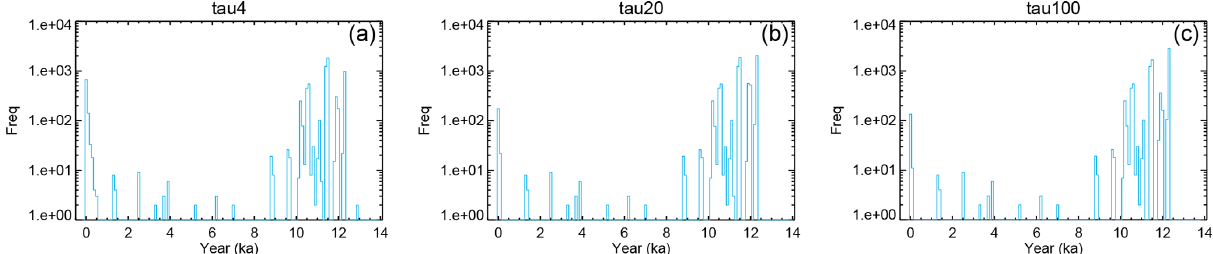
Figure 7. Histograms of circum-Arctic basal age distribution of the SOC accumulation for different values of τ : (a) 4 years, (b) 20 years, and (c) 100 years. The ordinate (frequencies) is in the logarithmic